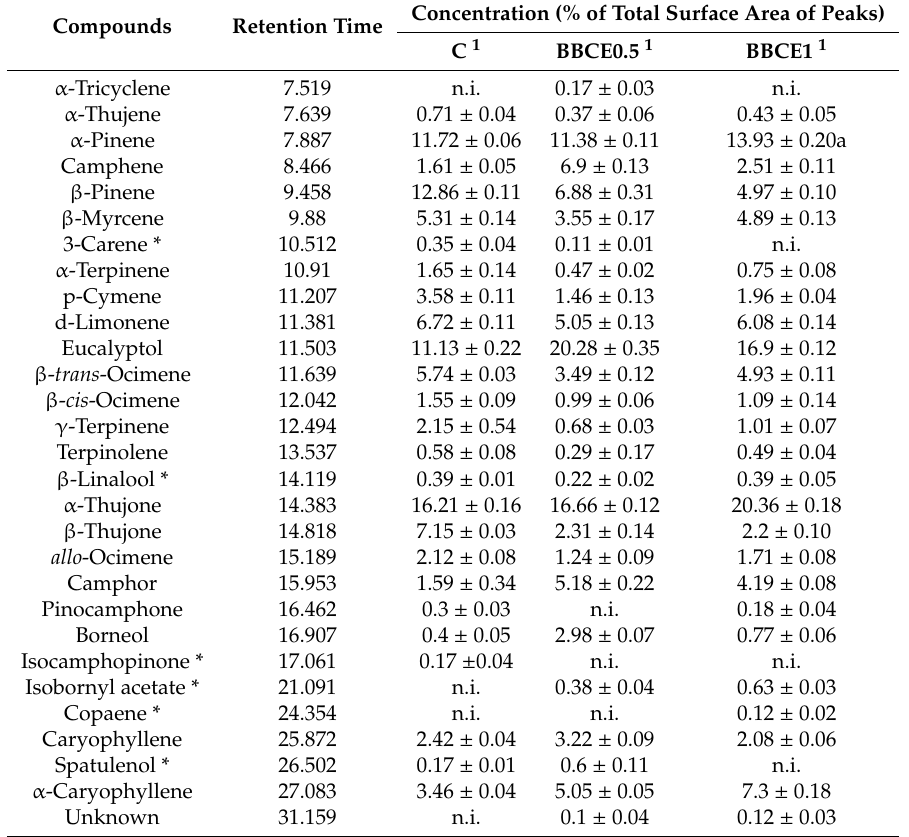
Table 5. Concentrations (peak area percent) of the volatile compounds from Salviae